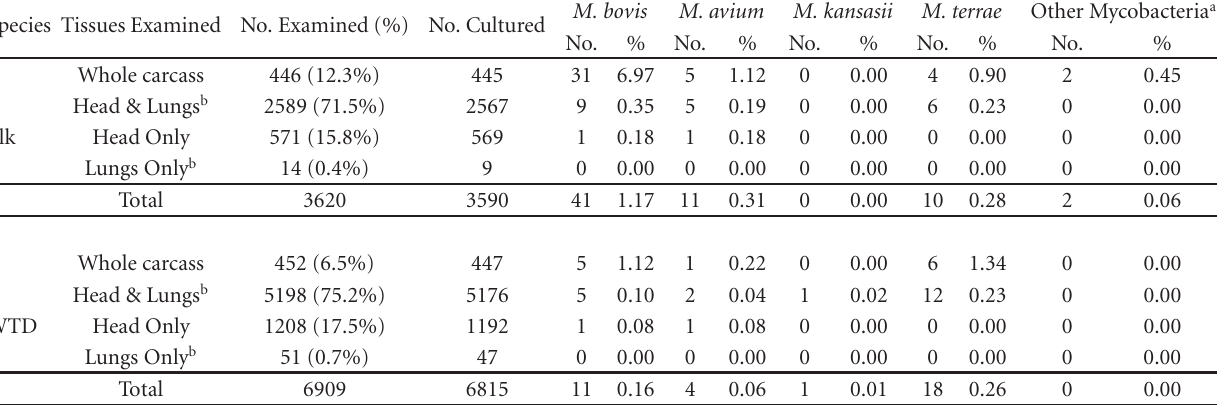
Table 2: Summary of gross pathological and culture results for infected deer and elk by number of tissues examined from south-western Manitoba.